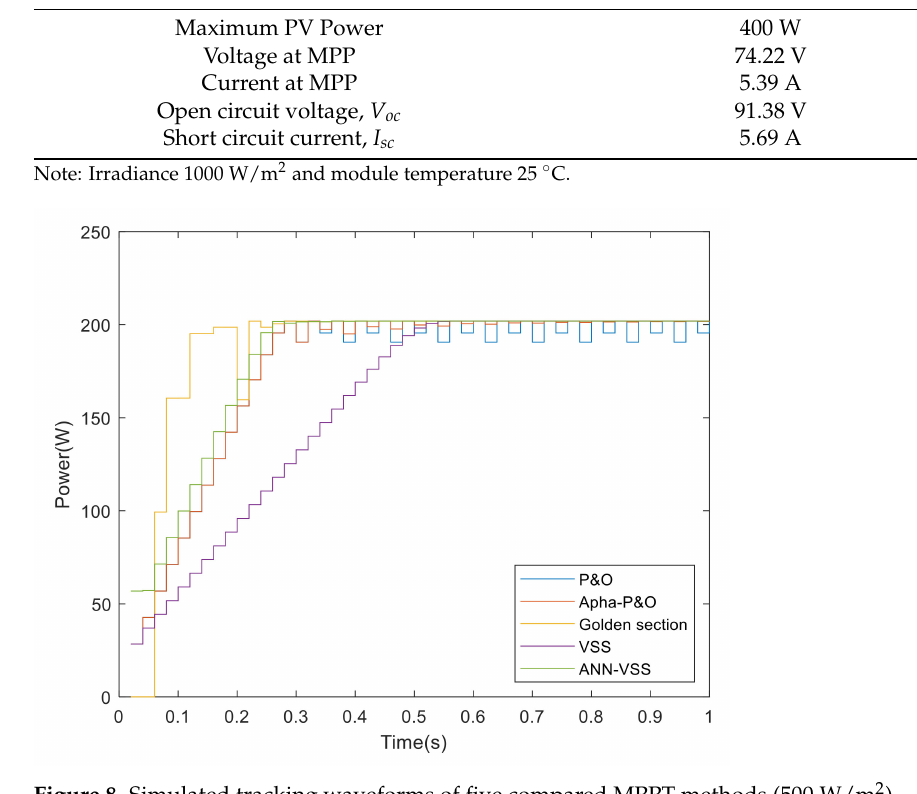
Figure 8. Simulated tracking waveforms of five compared MPPT methods (500 W/m 2